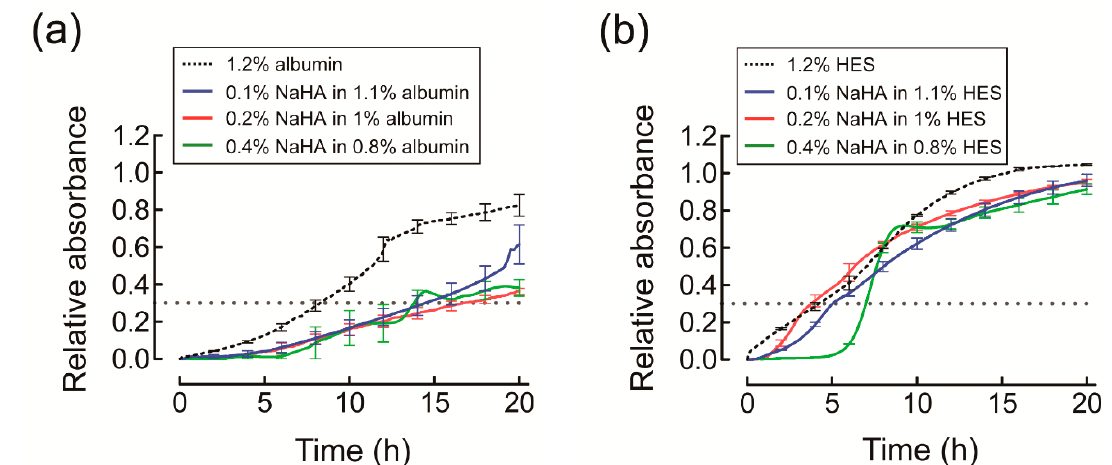
Figure 4. Time course of relative absorbance of Orange G permeating into different concentrations of sodium hyaluronic acid (NaHA) solution containing ( a ) albumin or ( b ) hydroxyethyl starch (HES). Relative absorbance of Orange G is expressed as a value relative to that calculated assuming that Orange G is uniformly distributed into NaHA solution in the ultraviolet cuvette. Experiments were carried out at least in triplicate. For simplicity, values are presented as mean and standard error for every 2 h. The dotted horizontal line indicates a relative absorbance of 0.3.